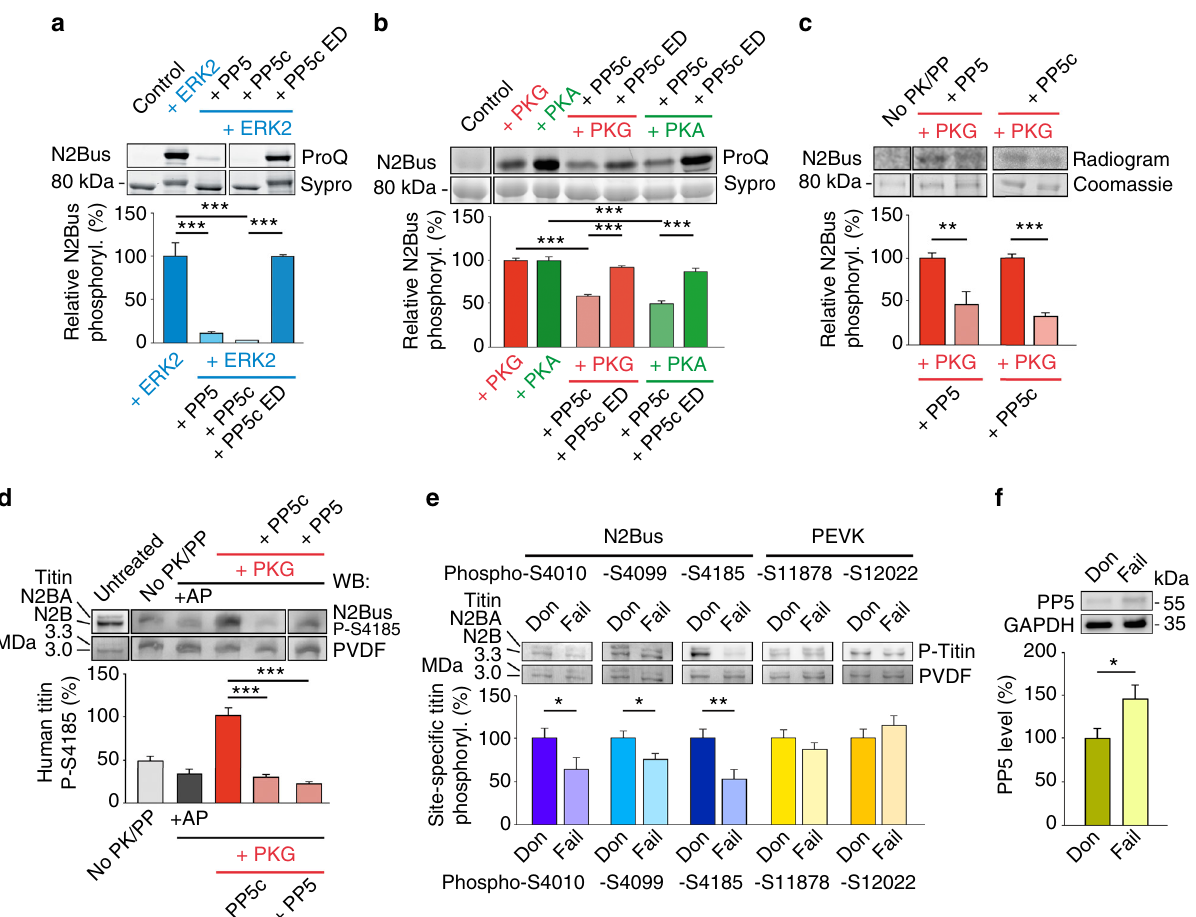
Fig. 3 PP5 dephosphorylates recombinant and endogenous human N2Bus. a , b ProQ Diamond phosphoprotein vs. Sypro Ruby total protein stain of human recombinant N2Bus phosphorylated (in presence of ATP) by ERK2 ( a ), catalytic subunit of PKA ( b ), or cGMP-activated PKG ( b ), and effect of human recombinant full-length PP5, PP5 catalytic subunit (PP5c), or enzymatic dead (ED) PP5c mutant H304A on phosphorylation. ‘ Control ’ is recombinant construct but no ATP/enzyme. n = 5. c 32 P-ATP autoradiography using N2Bus phosphorylated by cGMP-activated PKG and dephosphorylated by PP5 or PP5c. ‘ No PK/PP ’ is control in presence of 32 P-ATP, but no enzyme. n = 4. d Western blot (WB) of permeabilized human (donor) heart tissue treated with various enzymes, as follows: alkaline phosphatase (AP), cGMP-activated PKG, then PP5 or PP5c. Detection of titin phosphorylation with phospho-speci fi c antibody to P-S4185 in human N2Bus. PVDF was coomassie-stained to reveal loading on gel. WB signals were normalized to PVDF signals. n = 4. e Site- speci fi c phosphorylation of residues within N2Bus and PEVK titin regions by western blot in myocardial tissue from human donor (Don) and end-stage failing (Fail) hearts ( n = 10/group). Detection with phospho-speci fi c antibodies to P-S4010, P-S4099, P-S4185, P-S11878, and P-S12022 in the human titin sequence. WB signals were normalized to PVDF signals. f Mean PP5 expression in human donor vs. end-stage failing hearts ( n = 10/group). In a – f , bar graphs show relative phosphorylation indexed to the respective phosphorylated controls. Data are mean ± s.e.m.; * p < 0.05, ** p < 0.01, and *** p < 0.001, by two-tailed Student ’ s t -test or Holm-Sidak